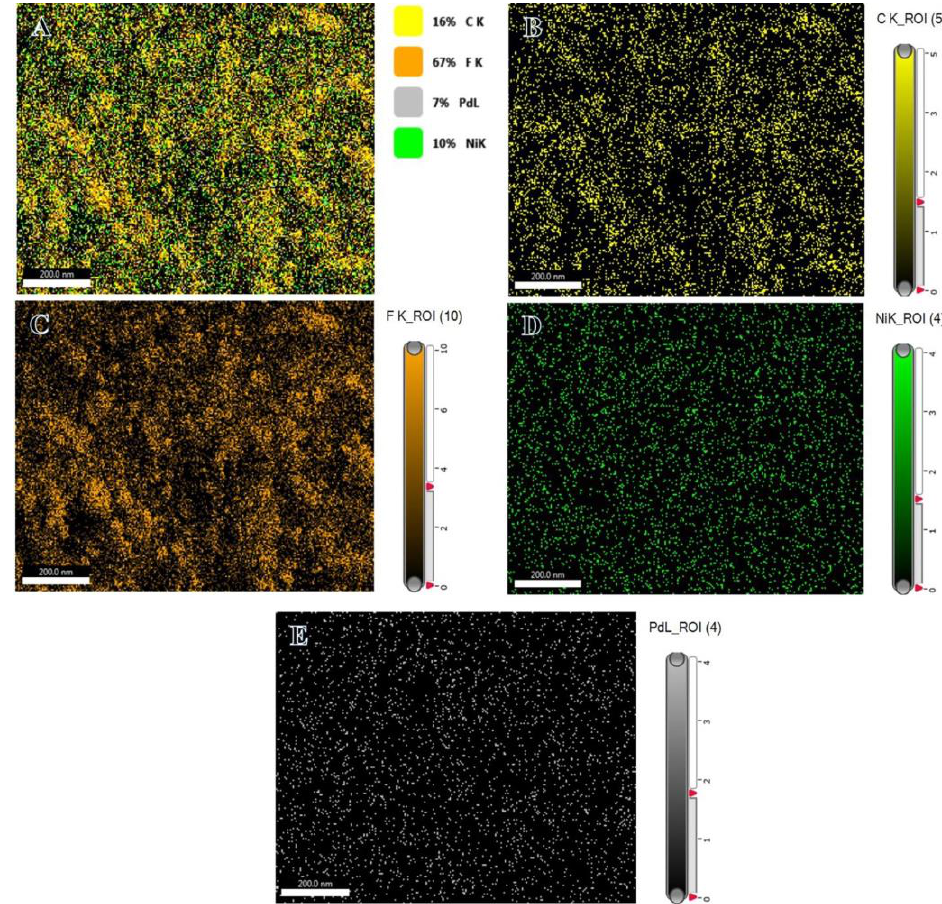
Figure 3. Map showing the allocation of elements ( A ), carbon ( B ), fluorine ( C ), nickel ( D ), and palladium ( E ) in the Ni 75 Pd 25 @PVDF-HFP membranes. palladium ( E ) in the Ni 75 Pd 25 @PVDF-HFP